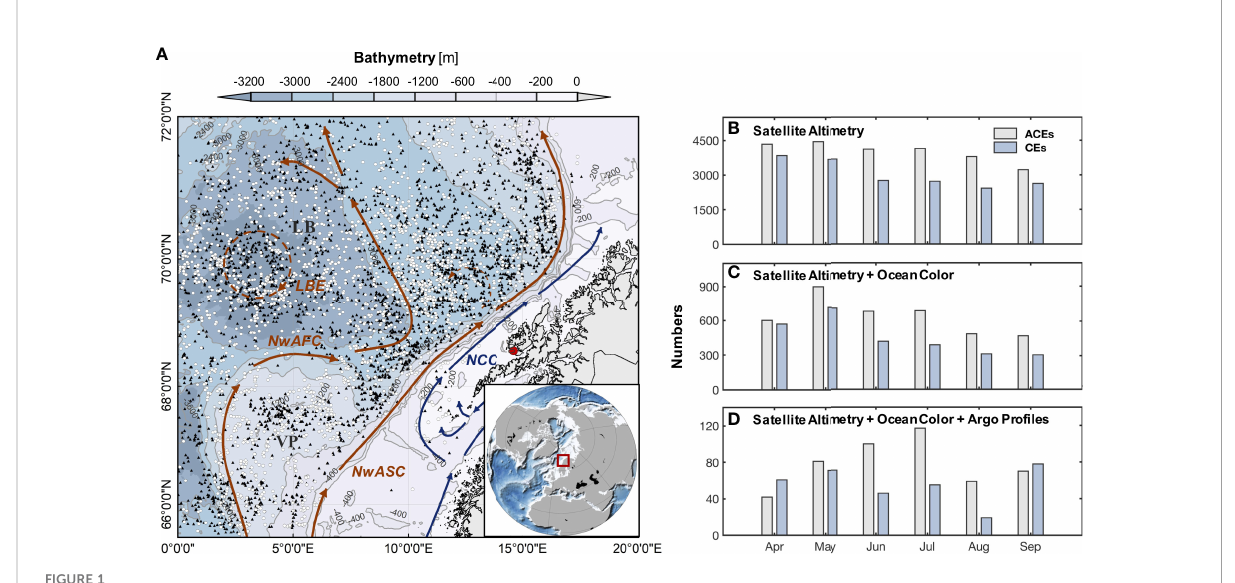
FIGURE 1 (A) Map of bathymetry and main currents in the northern Norwegian Sea. Locations of snapshots of anticyclonic eddies (ACEs) and snapshots of cyclonic eddies (CEs) detected by available ocean color data for April through September, 2000-2020 are shown by black triangles and white dots. The red dot represents the Lofoten-Vesterålen Islands. Histograms of monthly numbers of (B) all ACEs and CEs identi fi ed by satellite altimetry and hybrid algorithm, (C) identi fi ed ACEs and CEs based on (B) and covered by ocean color data, and (D) Argo fl oats occurring within ACEs and CEs based on (C)